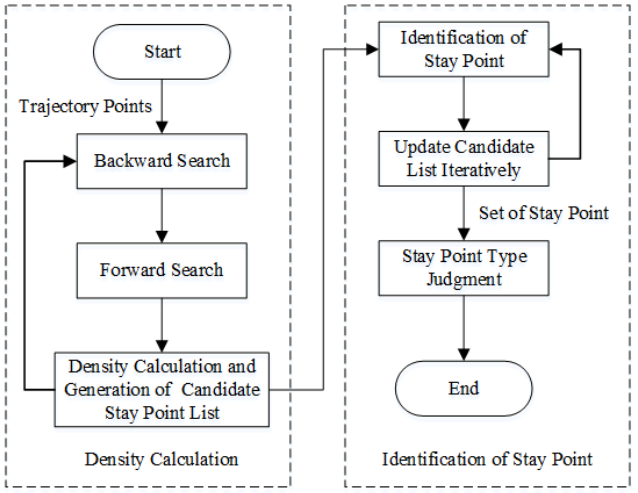
Figure 3. Algorithm framework of stay point detection.